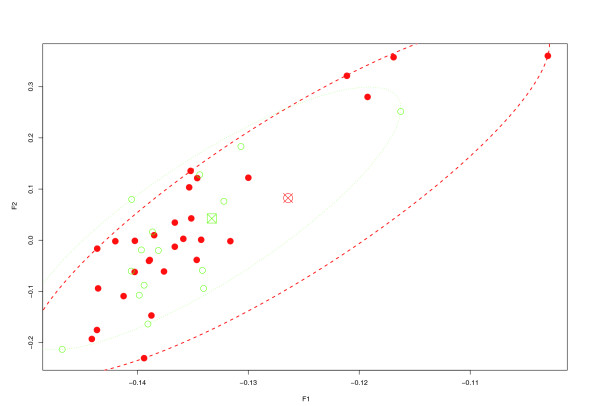
Principal component analysis of the samples at birth. The closed circles correspond to infants who did not develop bronchopulmonary dysplasia (BPD) and the open circles to those who did develop BPD. The centroid of the ellipsoid hull for each subgroup is illustrated with a symbol over-struck with an X (circle for controls and square for BPD). This plot illustrates the limited separation of these samples from the transcriptome-wide perspective. P > 0.05 for t-test in each of the principal components.